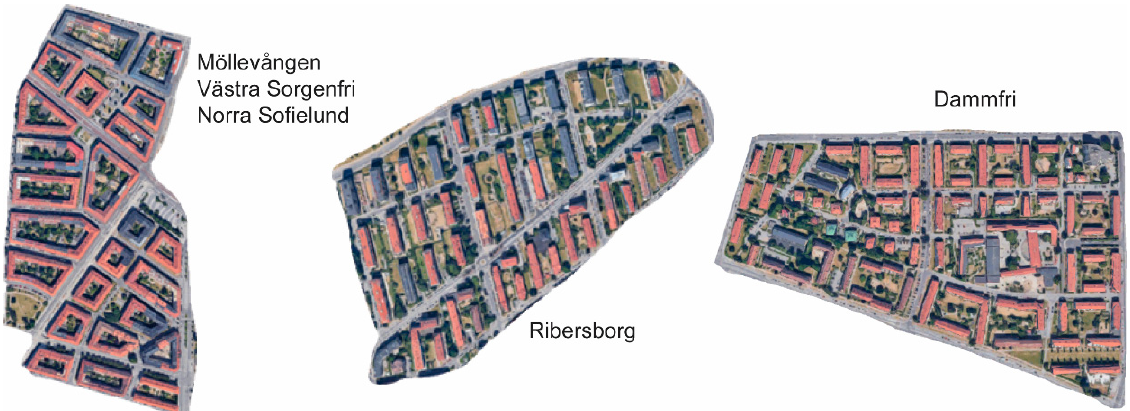
Figure 1. Examples of existing urban neighbourhoods and building types in Malmö, where slab and courtyard typologies prevail. Imagery ©2022 Google, Imagery ©2022 Lantmäteriet/Metria, Maxar Technologies, Map data ©2022.